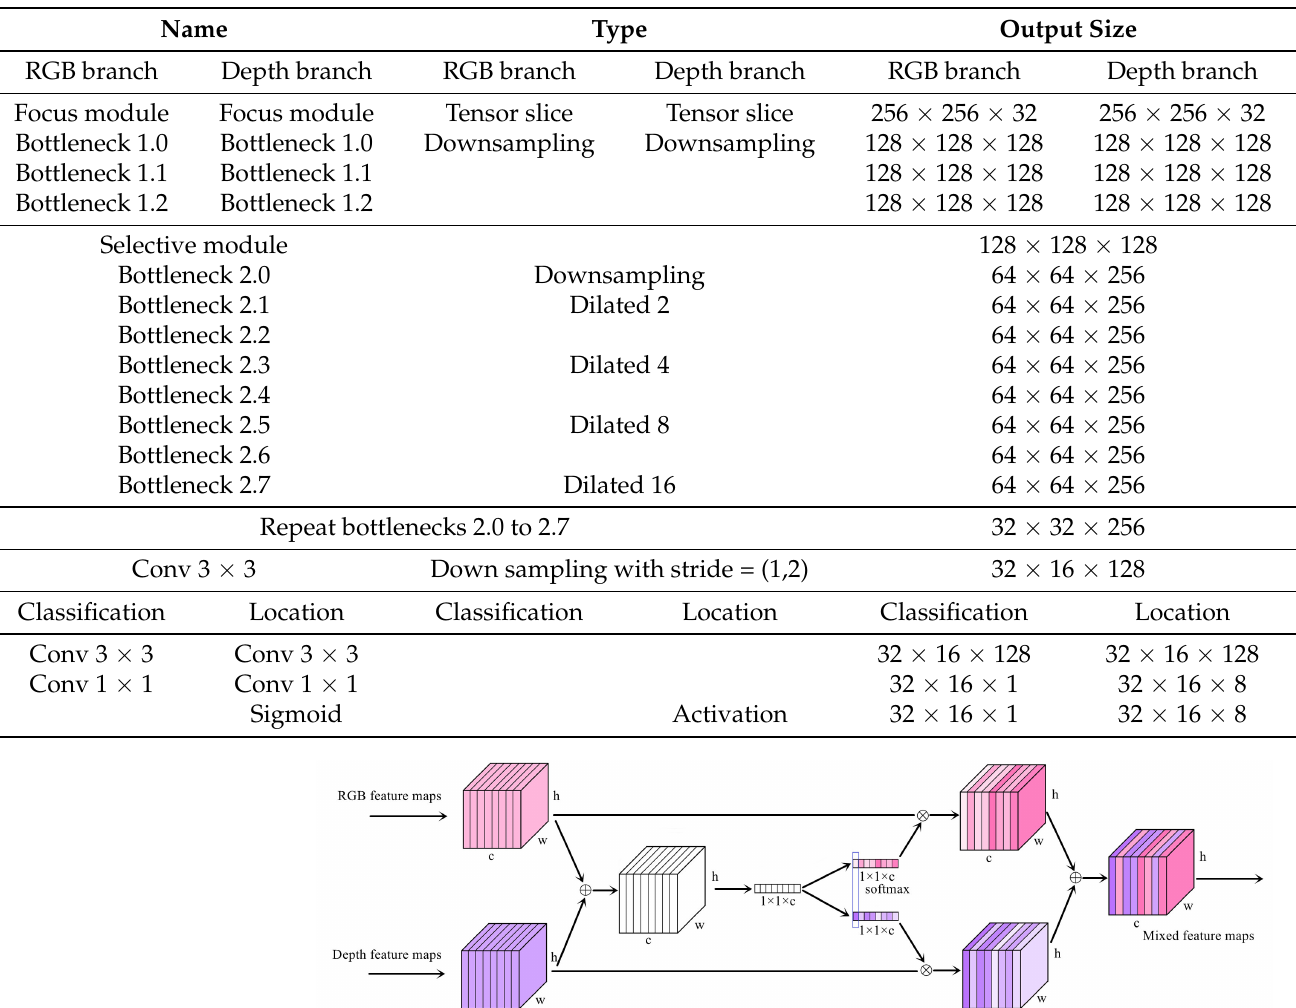
Table 1. StairNetV2 architecture with an input size of 512 × 512. For the output of the location branch, we add a sigmoid activation function to limit the values to (0,1) so that we can obtain the normalized locations of stair lines.